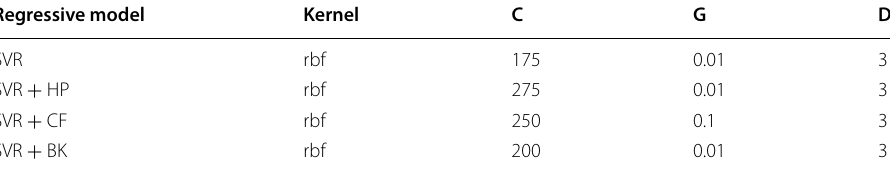
Table 5 Kernel parameters setting Regressive